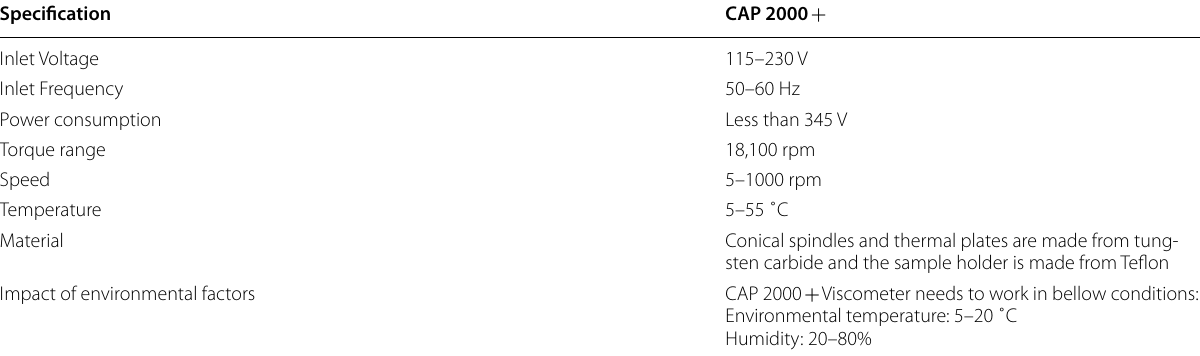
Table 1 Technical specifications of viscometer device Specification